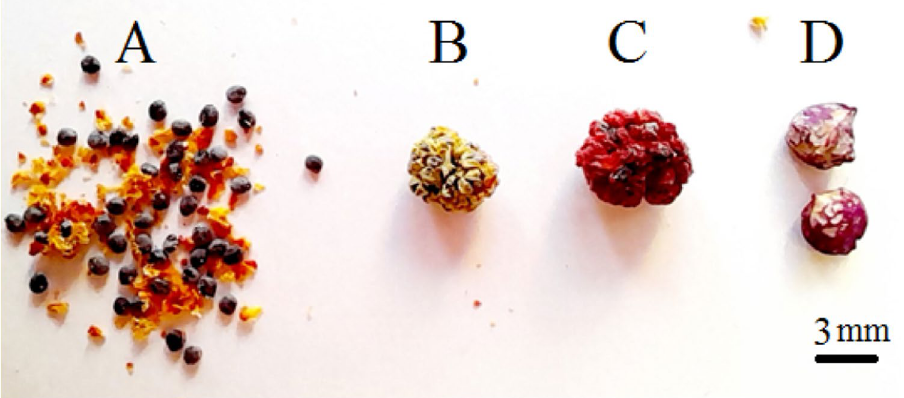
Figure 1. The comparison of seed size, seed color between B. virgatum [( A ) dried seed, ( B ) immature dried fruits, ( C ) matured dried fruit] and commonly cultivated spinach seeds ( D ).